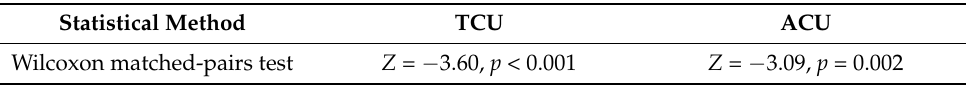
Table 6. Comparing task demand influence on the PERCLOS values by work types.